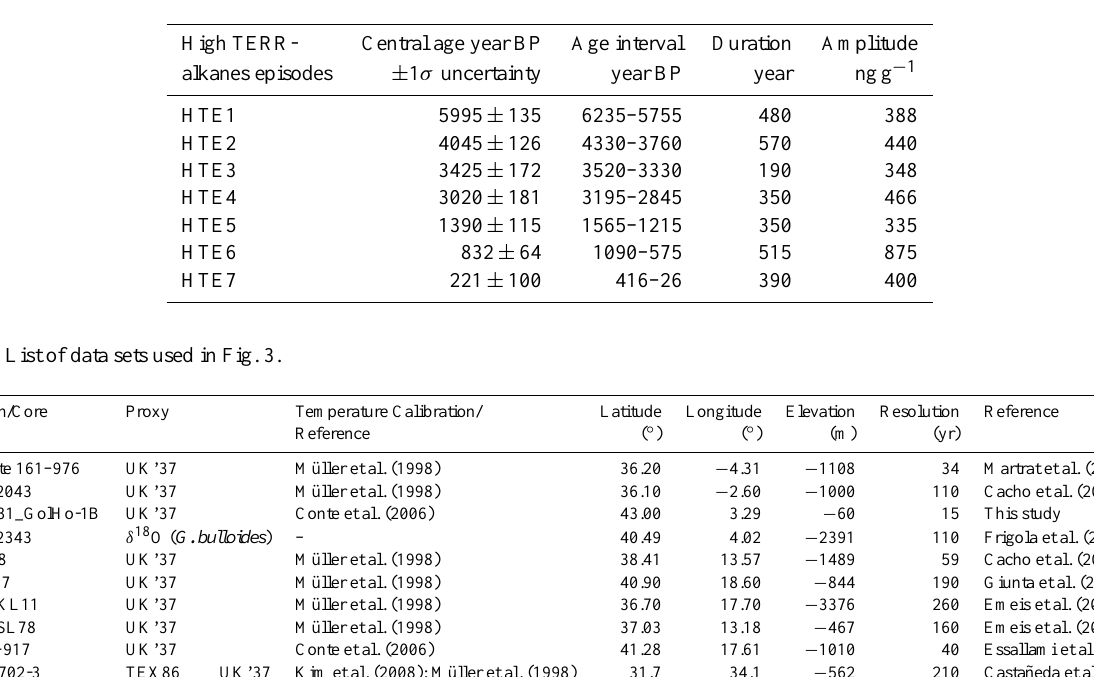
Table 3. Timing of high TERR-alkane episodes (HTE). Age uncertainty was estimated using a Bayesian approach of OxCal 4.2. HTE were defined as the time span where values exceed one half of the standard deviation of the Holocene mean value after applying a 60 yr Fast-Fourier Transform (FFT) analysis. Amplitudes were determined by the difference between highest TERR-alkanes and the value at the beginning of HTE.